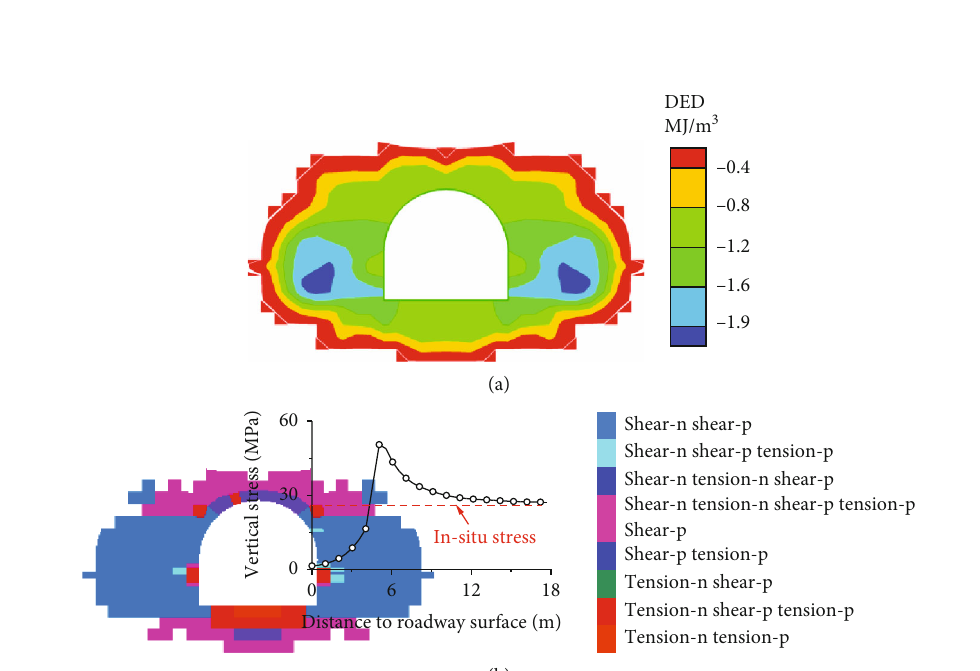
Figure 4: Numerical simulation results. (a) and (b) represent the evolvements of roadway dissipated-energy density (DED) and plastic zone, respectively. The curve in (c) is the vertical stress distribution of the roadway